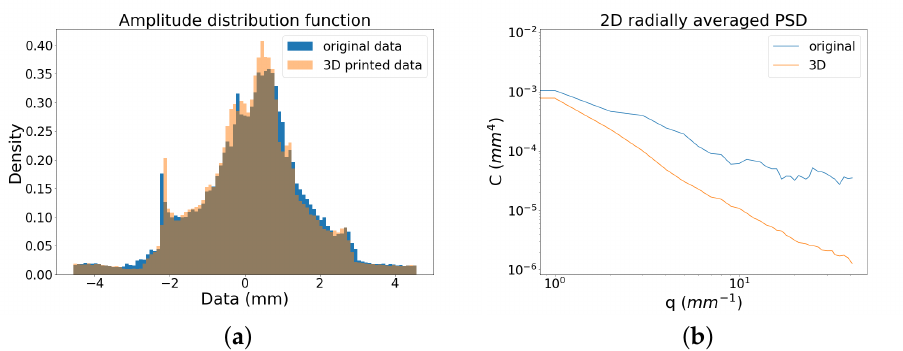
Figure 12. Signal of the original surface and 3D printed replica: ( a ) height distribution and ( b ) power spectrum.